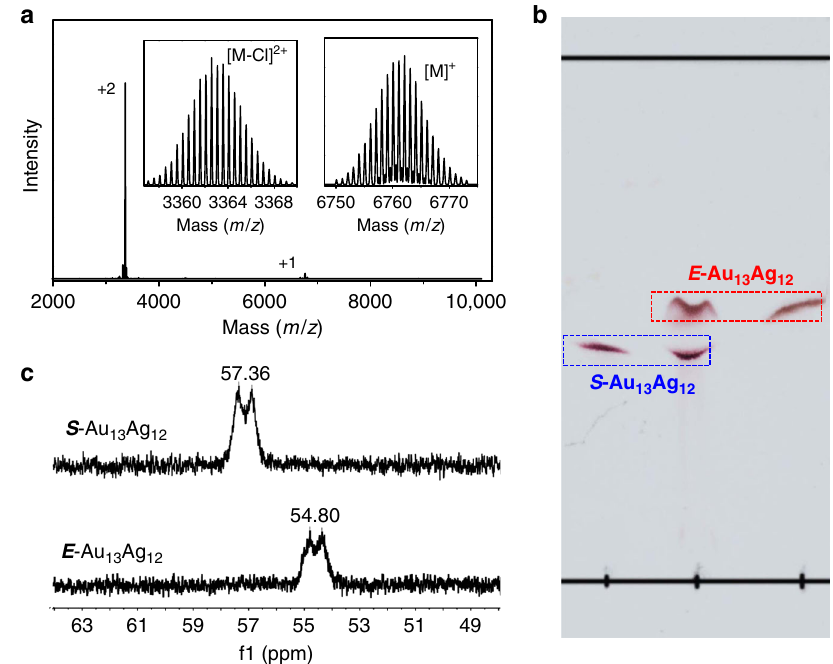
Fig. 2 Characterization of the Au 13 Ag 12 nanoclusters. a Positive-mode ESI mass spectrum of the as-synthesized Au 13 Ag 12 nanocluster. (M = Au 13 Ag 12 (PPh 3 ) 10 Cl 8 ) b Thin-layer chromatography separation of the Au 13 Ag 12 using CH 2 Cl 2 /CH 3 OH (2:1, v/v) as an eluent. c 31 P NMR spectra of the S -Au E -Au 13 Ag 12 and 13 Ag 12 in CD 2 Cl 2 .